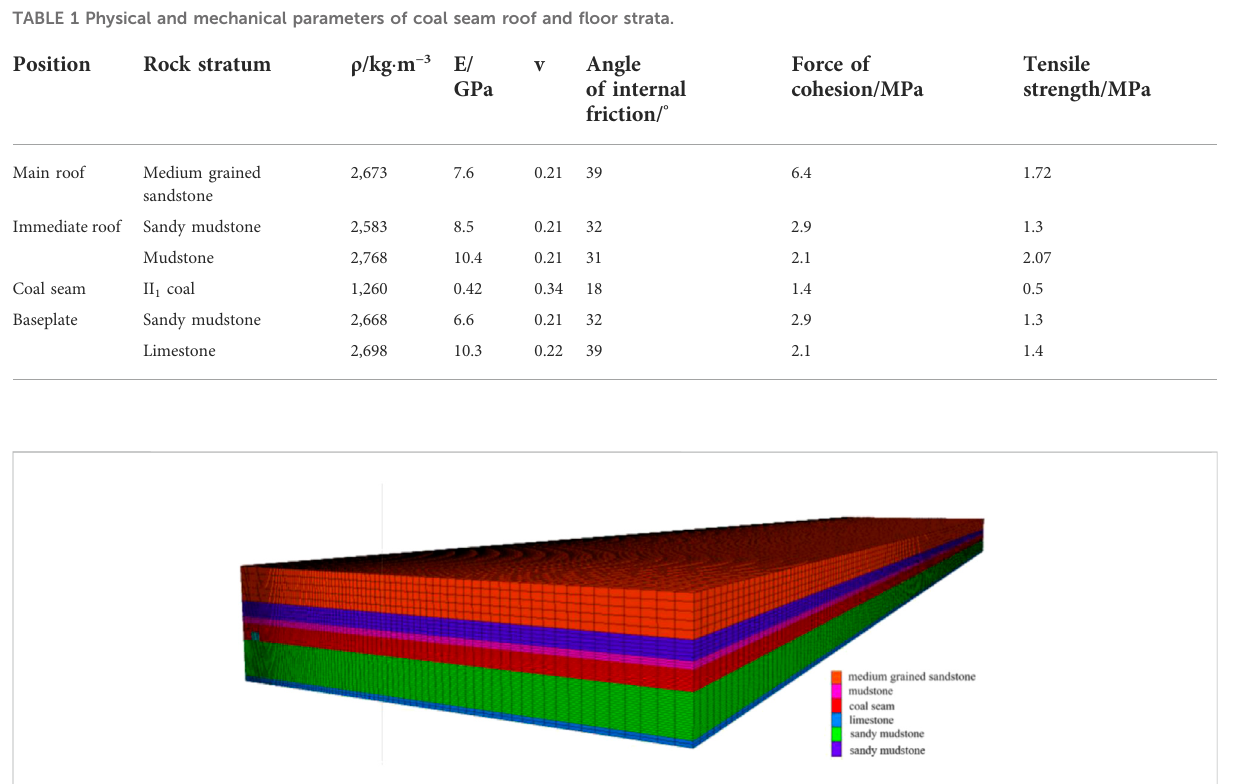
FIGURE 7 Numerical calculation model.